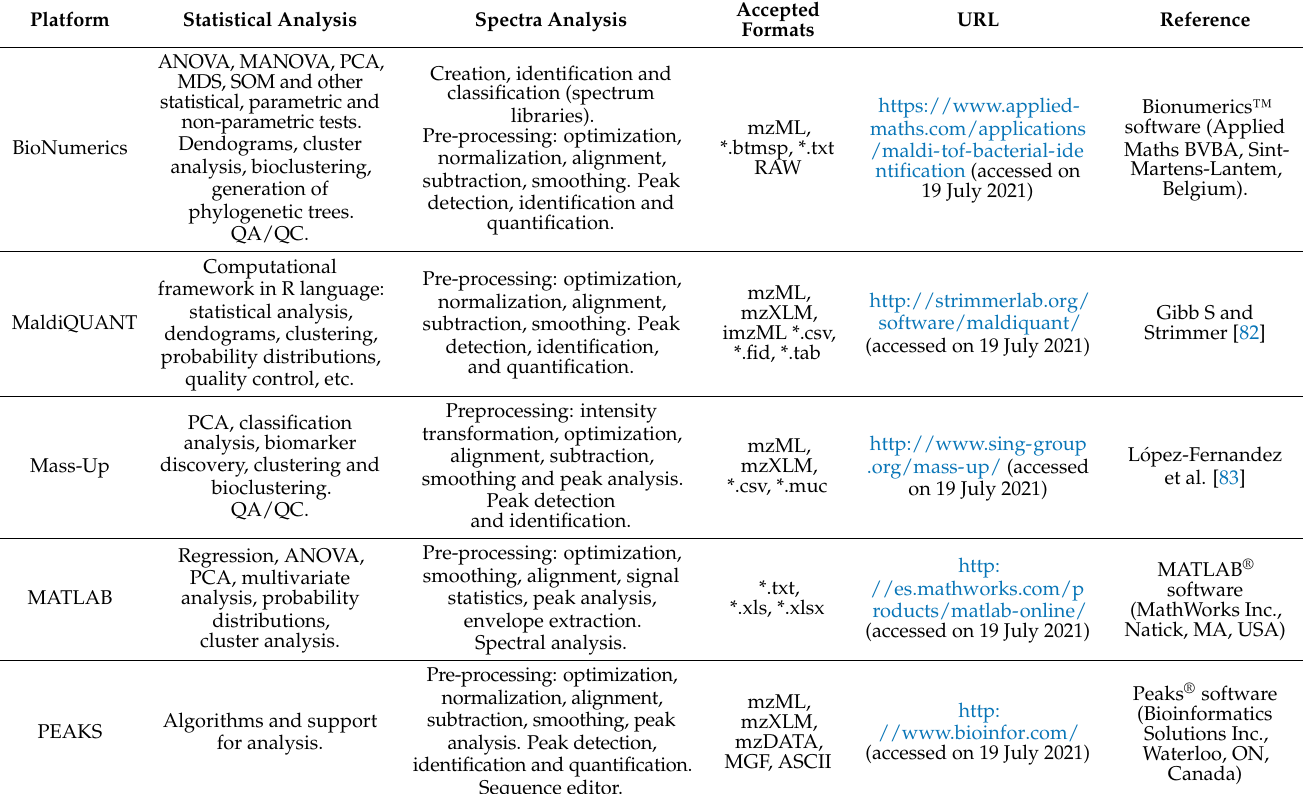
Table 1. Overview of platforms for the analysis of big MS data of acquired mass spectra from MALDI–TOF MS. MDS: Multi-dimensional Scaling; PCA: principal component analysis; QA/QC: Quality Assurance/Quality Control; SOM: self-organization